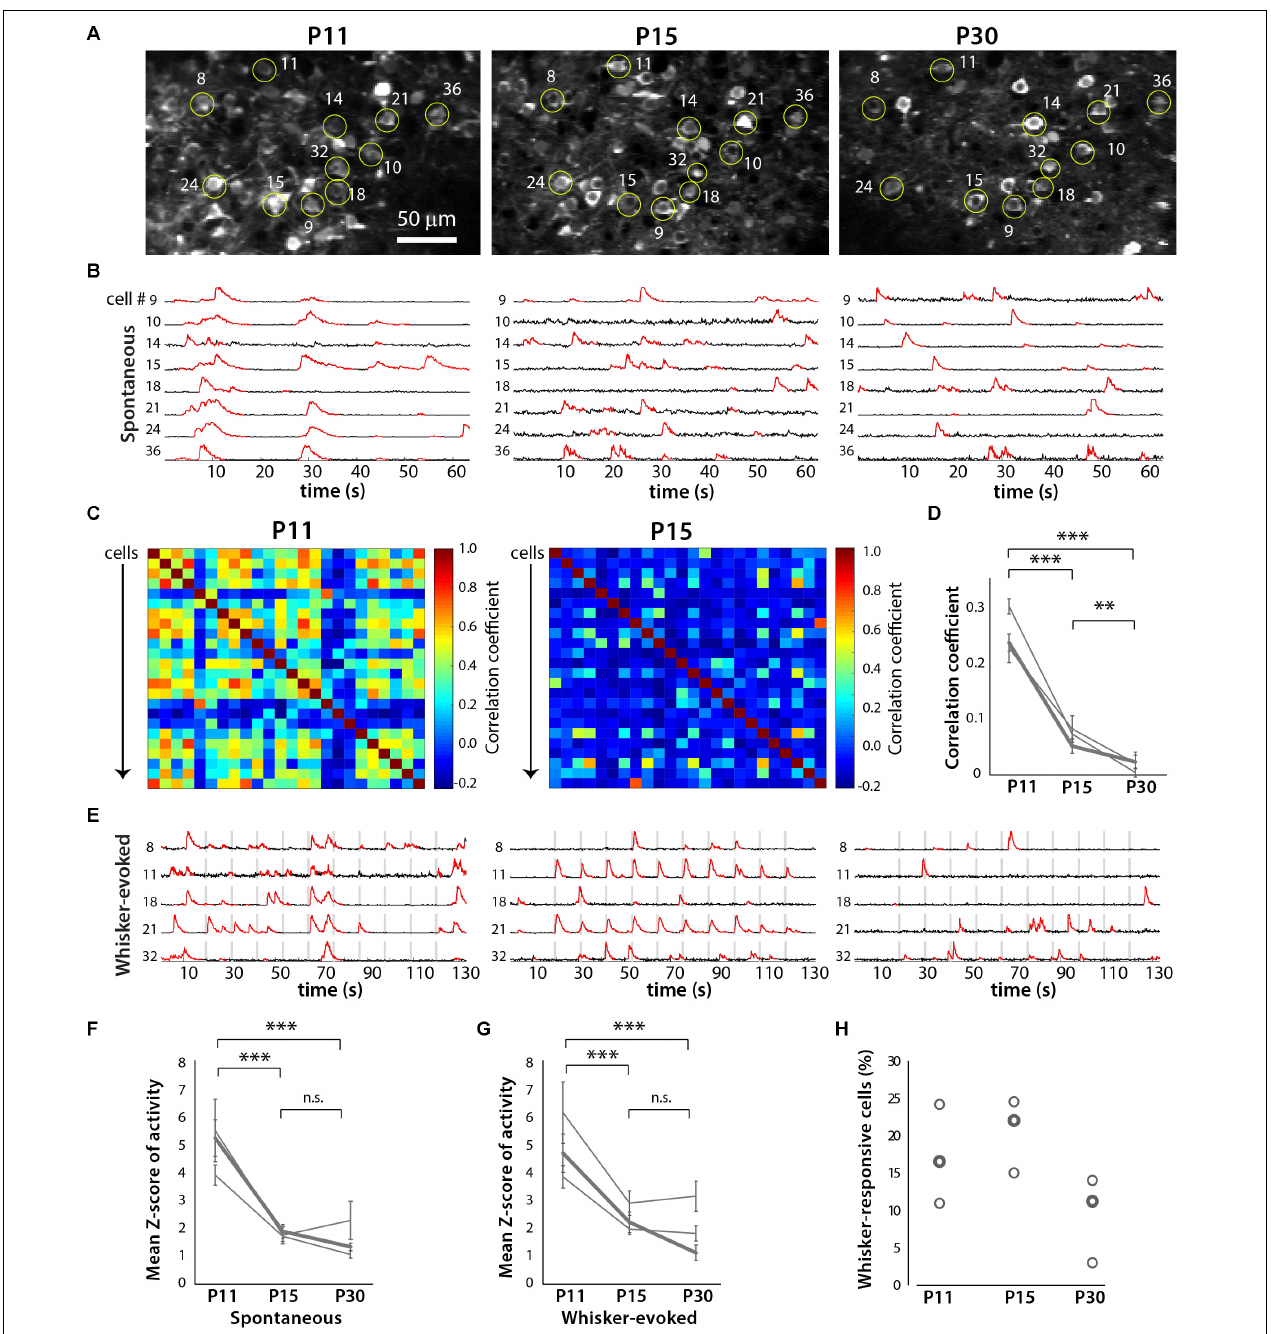
FIGURE 6 | Developmental desynchronization of network activity in barrel cortex. (A) Example field of view for a two-photon imaging recording of GCaMP6s-expressing layer (L) 2/3 neurons in barrel cortex from a representative in vivo experiment at P11, P15, and P30 ( xyt SD projection of 1,040 consecutive frames at 7.8 Hz). Example cells that could be identified at all three ages are labeled by yellow circles and numbers. For some of these cells, the corresponding fluorescence calcium traces are shown in panels (B,E) . (B) Spontaneous activity (cid:49) F/F calcium traces of eight individual L2/3 neurons from the same field of view as in (A) , at P11, P15, and P30. (C) Correlation matrices displaying the correlation coefficients between the deconvolved calcium traces of all possible pairs of cells ( n = 24) shown imaged in (A) . (D) Pair-wise correlation coefficients across developmental ages for three different mice. The bold line indicates data from the example recording shown in panels (A–C,E) . ∗∗ p < 10 − 3 , ∗∗∗ p < 10 − 5 . (E) Whisker-evoked activity (cid:49) F/F calcium traces of eight individual L2/3 neurons from the same field of view as in panel (A) , at P11, P15, and P30. Vertical gray bars represent epochs of whisker deflection (10 Hz, 1 s duration, 10 s i.s.i.). (F) Magnitude of spontaneous activity (as determined by average Z scores of calcium traces). In panels (F,G) , the bold line indicates data from the example recording shown in panels (A–C,E) . ∗∗∗ p < 10 − 5 . (G) Magnitude of whisker-evoked activity (average Z scores). ∗∗∗ p < 10 − 5 . (H) Percentage of all L2/3 neurons imaged whose activity was time-locked to epochs of whisker stimulation (see Materials and Methods) for all three mice ( n = 296, 401, and 248 neurons respectively).